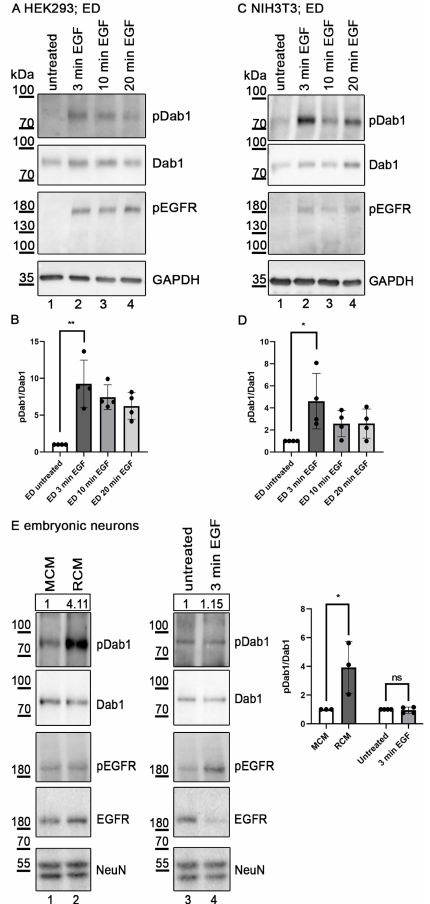
Figure 2. EGF induces Dab1 phosphorylation. Western blot analysis of protein extracts from HEK293 ( A ) and NIH3T3 ( C ) cells expressing EGFR and Dab1. Cells were either left untreated (Lane 1) or treated with human EGF (10 ng/mL) for 3 (Lane 2), 10 (Lane 3), or 20 min (Lane 4). Immunoprecipi- tation using a Dab1 specific antibody was performed (Ab 54). Dab1 phosphorylation levels (Panel A1/C1) were detected using an antibody against phosphorylated tyrosine residues (Ab PY99). The blots were stripped and re-probed for Dab1 using Ab D4 (panel A2/C2). Extracts were blotted with an antibody specific for phosphorylated EGFR (Tyr 1173) (panel A3/C3). As a loading control, GAPDH was used (Panel A4/C4). Anti-phosphotyrosine signal was normalized to the anti-Dab1 signal and relative levels of phosphorylated Dab1 from 4 independent experiments in HEK293 ( B ) and NIH3T3 ( D ) are presented. The levels of Dab1 phosphorylation in the untreated controls were set to 1. Data were analyzed by an unpaired, two-tailed t -test. ( E ) Primary neuronal cultures (DIV7) were treated with Reelin conditioned medium (RCM, Lane 2), Mock conditioned medium (MCM, Lane 1) for 20 min or with 20 ng/mL murine EGF for 3 min (Lane 4) or left untreated (Lane 3). Cells were lysed and the protein extracts were subjected to immunoprecipitation using an antibody specific to Dab1 (Ab 54). Dab1 phosphorylation levels (Panel 1) were detected using an antibody against phosphorylated tyrosine residues (Ab PY99). The blot was stripped and re-probed for Dab1 using Ab D4 (Panel 2). Extracts were blotted with an antibody specific for phosphorylated EGFR (Tyr 1173) (Panel 3), total levels of EGFR (Panel 4). As a neuronal loading control, Ab NeuN was used (Panel 5). The extracts and precipitates were analyzed by western blotting. Bands were scanned with ChemiDoc Touch Imaging System (BioRad), the anti-phosphotyrosine signal was normalized to the anti-Dab1 band and relative levels of phosphorylated Dab1 from 3–4 independent experiments are presented. The levels of Dab1 phosphorylation in the untreated or mock controls were set to 1. Relative intensity of the presented blot is shown in a box above the first panel. Data were analyzed by way of an unpaired, two-tailed t -test, * p ≤ 0.05, ** p ≤ 0.01, ns, not significant; dotes, number of experiments. Error bars represent standard